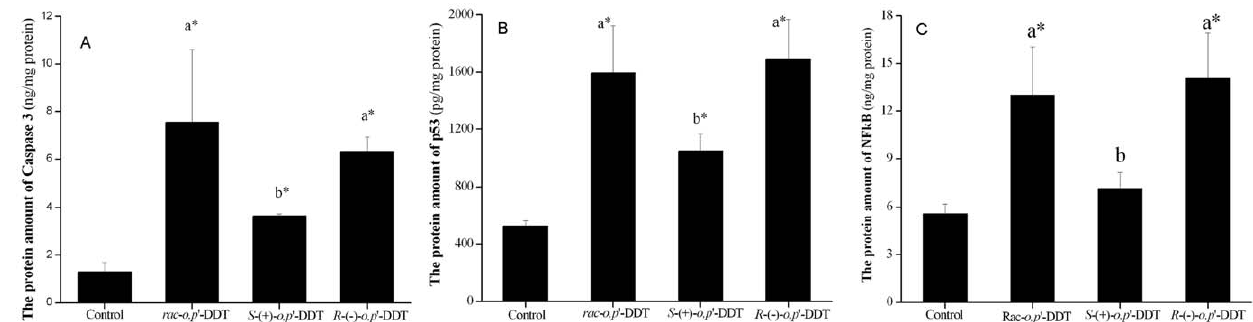
Figure 5. Apoptotic related proteins induced by racemate and enantiomers of o,p’-DDT. The protein expression of (A) p53, (B) caspase3 and (C) NF k B after exposured to rac - o,p ’-DDT, R -( + )- o,p ’-DDT, and S -( 2 )- o,p ’-DDT. The asterisk indicates p , 0.05 relative to a negative control. Different capitalized letters above adjacent bars indicate a significant difference ( p , 0.05) between individual enantiomers or between an enantiomer and racemate, while the same letter indicates no significant difference. doi:10.1371/journal.pone.0043823.g005 Figure S1 Cell proliferation test results for rac - o,p ’-DDT (A) and two enantiomers of o,p ’-DDT (B). (TIF)